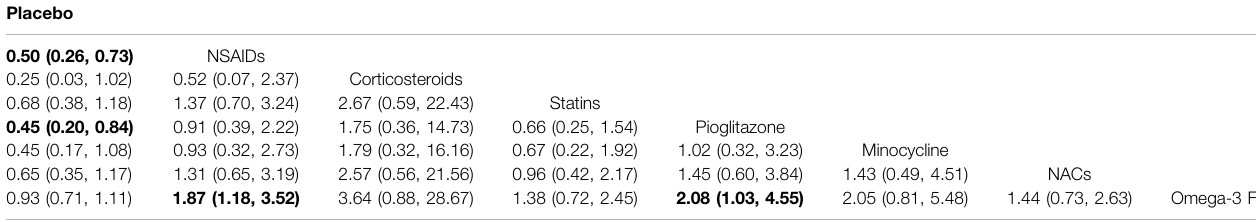
TABLE 2 | Network meta-analysis comparisons for ef fi cacy. Placebo